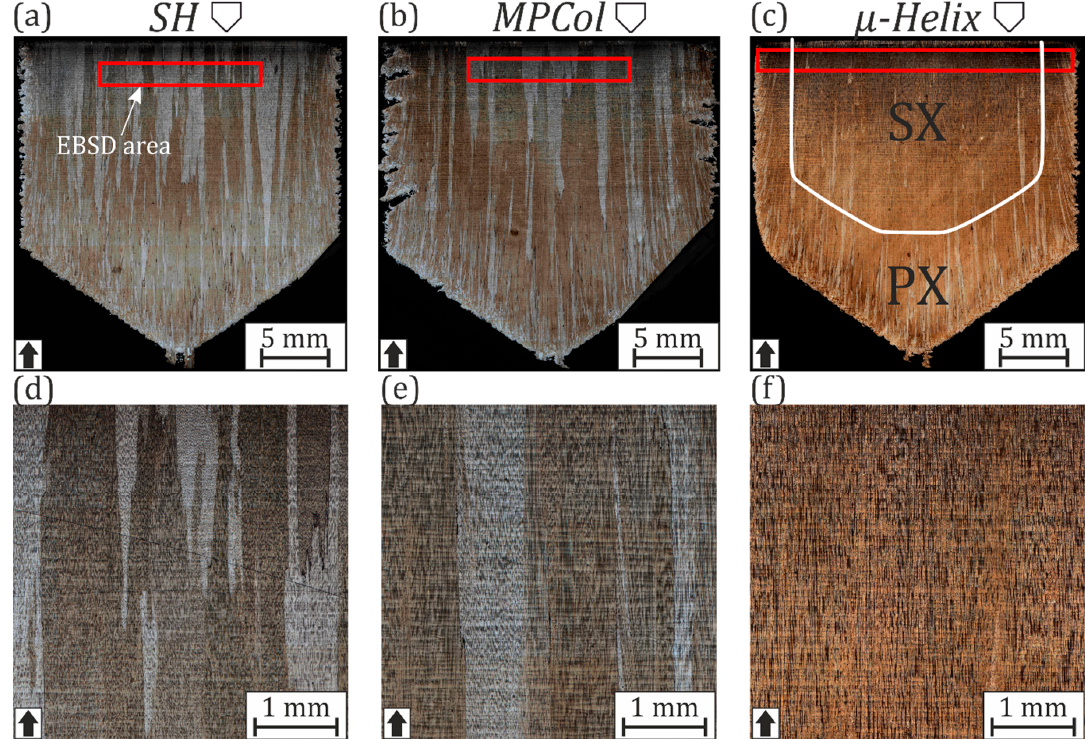
Figure 3. Macro-etched longitudinal sections ( a – c ) and corresponding detailed pictures ( d – f ) from trapezoidal prisms manufactured with different SEBM processing parameters and aperture angles of 35°. The build direction is indicated by the black arrows. The µ-Helix parameter setting allows the fabrication of technical single crystals (SXs). For convenience, the SX region (white), as well as the areas for the electron backscatter diffraction (EBSD) measurements are highlighted (red). SH— standard hatching; MPCol—multi passing.